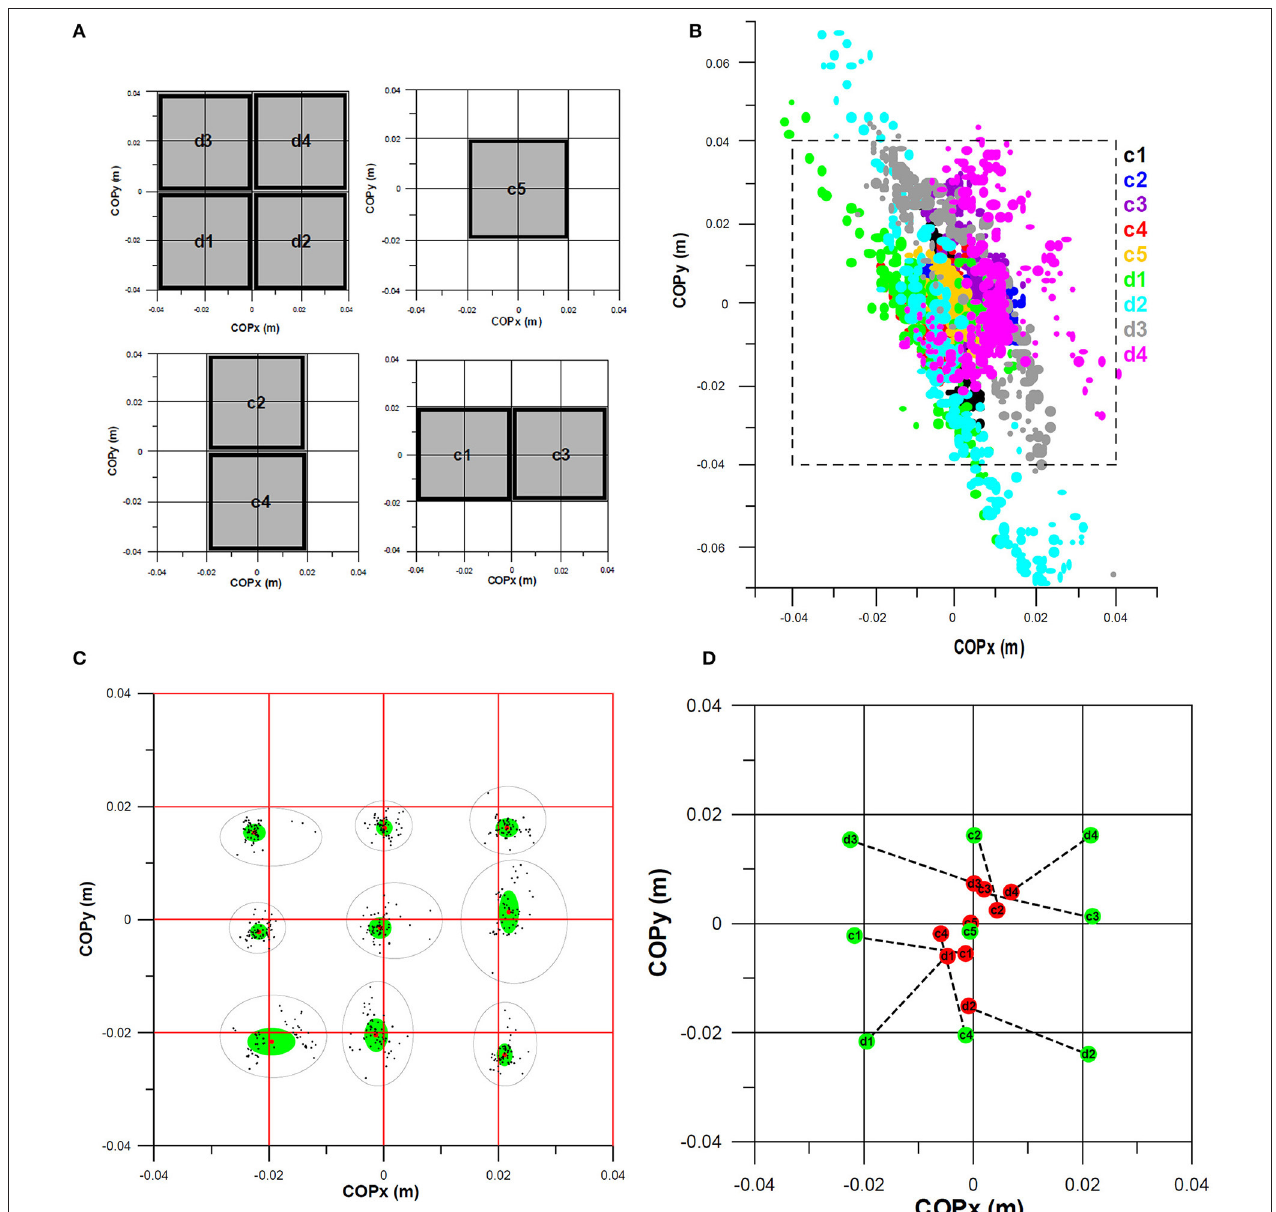
FIGURE 1 | Pressure sensor matrix and its validation against a Kistler force plate; COPx, COPy: position of the center of pressure in x- and y-direction of the coordinate system of the sensor matrix; (A) 4 × 4 sensor matrix and the positions (d1–d4, c1–c5) of the spacers for impact loading of nine 2 × 2 quarters for validating the position of the center of pressure (COP); (B) COPs obtained from the force plate with respect to the sensor matrix (dashed black square; note that COPs cannot be outside the sensor matrix; yet, the force plate returned impossible COP positions); (C) COPs obtained from the pressure sensor matrix (black dots: COP position; red dots: average position; green ellipse: area of one standard deviation of COPx and COPy with respect to the average, black elliptic contour: cluster of all COP positions per quarter; note that the average COPs are not exactly at the center of each quarter as it was impossible to impart the impact force exactly at the center of each spacer); (D) Comparison of average COPs obtained from the force plate (red) and the pressure sensor matrix (green). © Yehuda Weizman, reproduced from Weizman (2016) with kind permission.